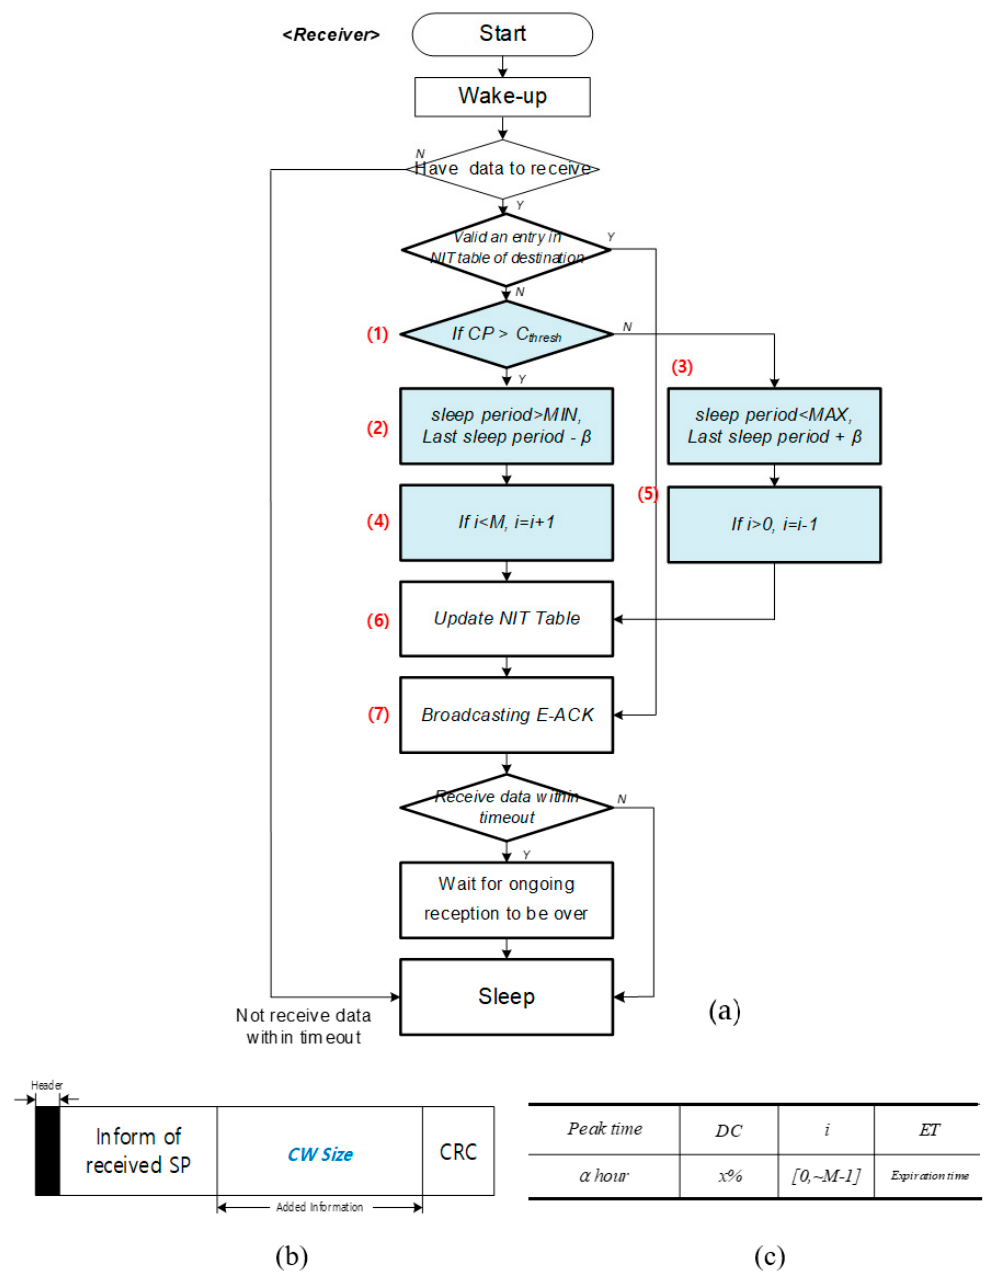
Figure 5. Structure of the DDC-MAC protocol: ( a ) algorithm; ( b ) frame; ( c ) CW size information.